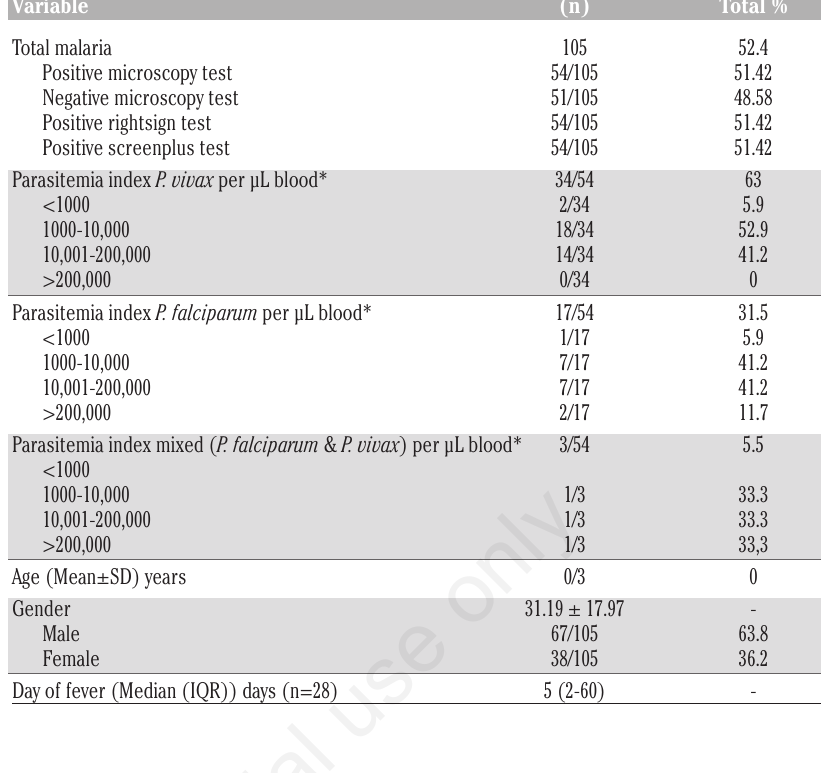
Table 1. Basic characteristics of subjects and study samples.